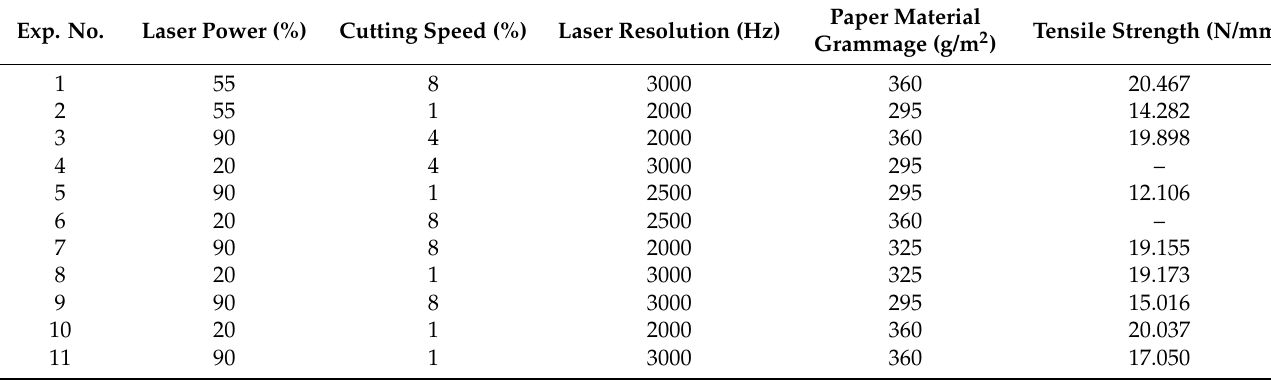
Table 3. DSD experimental design and